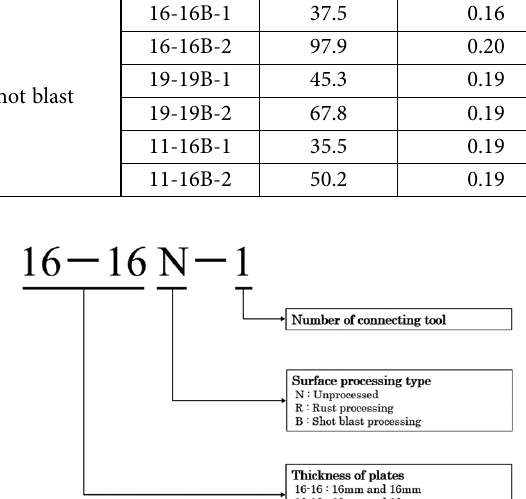
Figure 6. Shape of the steel coupon for tensile test